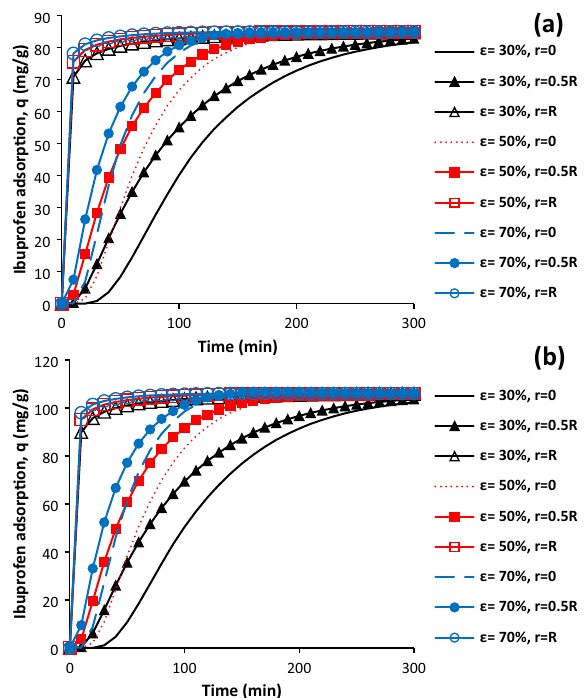
Figure 6. Effect of particle porosity on the ibuprofen adsorption for AC ( a ) and SAC ( b ), initial ibuprofen concentration = 100 mg/L, T = 298 K, pH = 2, adsorbent dosage of 0.5 g/L, and particle radius = 163 µm.